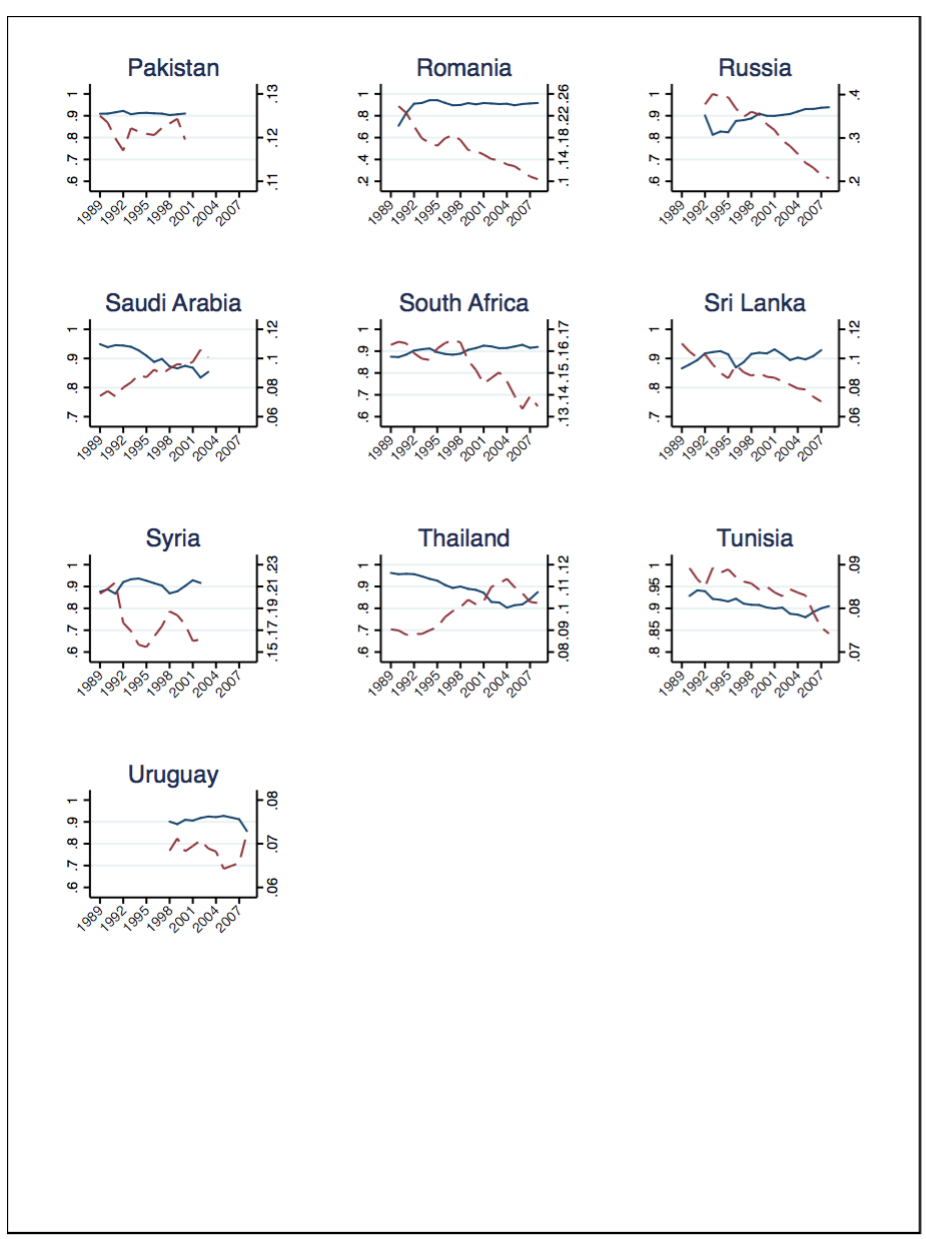
Figure 4. Comparison of estimated ‘true energy efficiency with energy intensity by